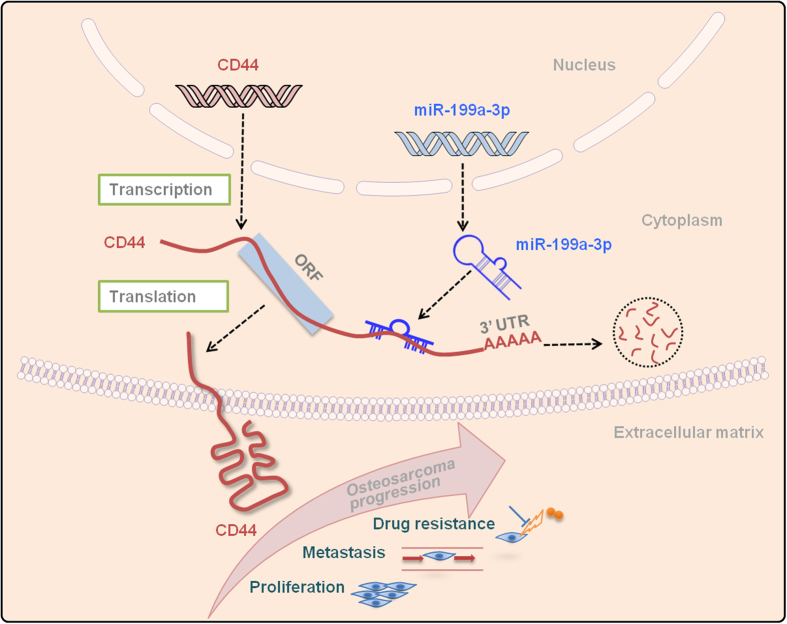
Schematic representation showing CD44-miR-199a-3p axis mediated aggressive behaviors in osteosarcoma.The miR-199a-3p can bind the site within the 3′-UTR of CD44 mRNA, which leads to degradation of the bound RNA. Upregulation of miR-199a-3p in osteosarcoma reduces the expression of CD44 mRNA and leads to decreased translation of the functional CD44 protein. On the other hand, overexpression of CD44 oncoprotein plays critical roles in promoting proliferation, metastasis, and drug resistance during osteosarcoma progression.